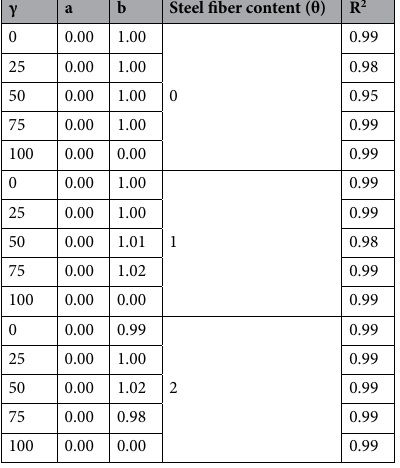
Table 7. Results of γ-value parameter analysis (Flexural strength fitting).